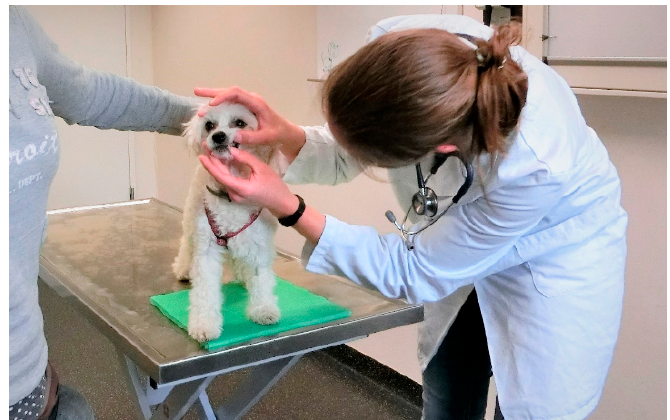
Figure 10. Animals can be trained to perform a ‘consent behaviour’ such as stepping onto a target mat to indicate when they are ready for manipulations. When the animal interrupts the behaviour, any manipulations are stopped, thus giving the animal control. Photo: Stefanie